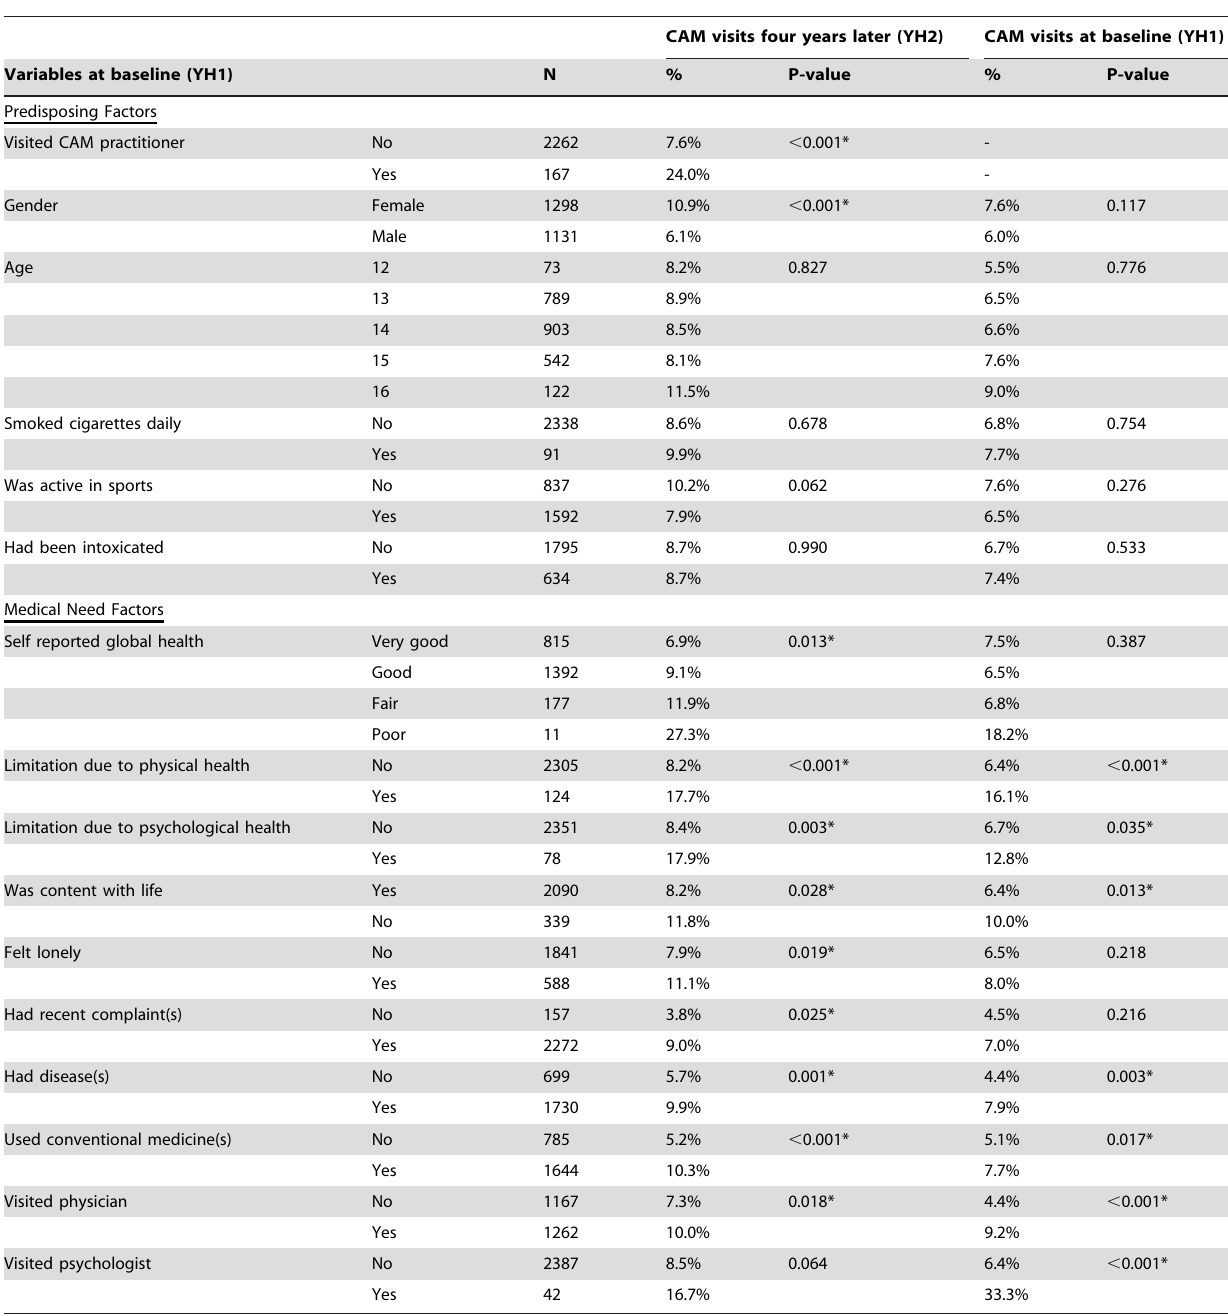
Table 1. Bivariate analysis of baseline variables and 1) future visits to CAM practitioner and 2) baseline CAM visits (N =2429).